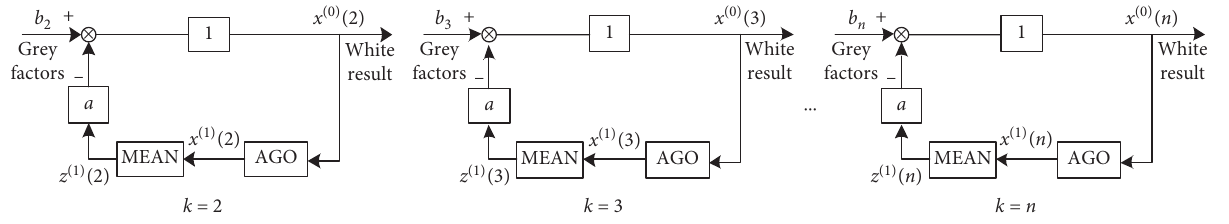
Figure 2: Corresponding relationship between input and output of GM(1,1).